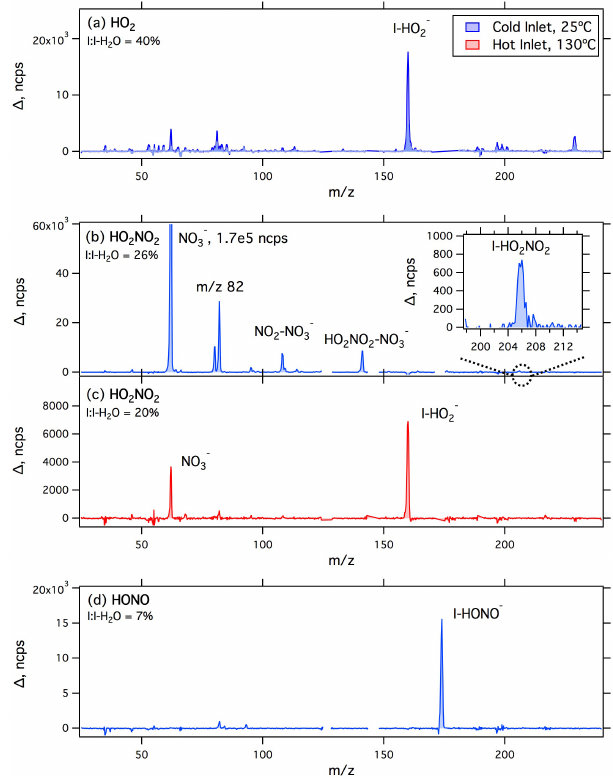
Figure 1. Shown are normalized (1 e 6cps I − ) , background- corrected mass spectra acquired in the laboratory for calibration sources of HO 2 (a) , HO 2 NO 2 (b) and (c) , and HONO (d) . Spec- tra colored in blue were collected using a room temperature inlet ( ∼ 25 ◦ C) while spectra in red indicate that an inlet dissociator at a temperature of 130 ◦ C was used. Background mass spectra have been subtracted from the displayed mass spectra to highlight the m/z ions that are produced via the I − CIMS ion chemistry. All three species are detectable at a unique m/z , when an inlet dissociator is not used, allowing for simultaneous detection of HO 2 , HO 2 NO 2 , and